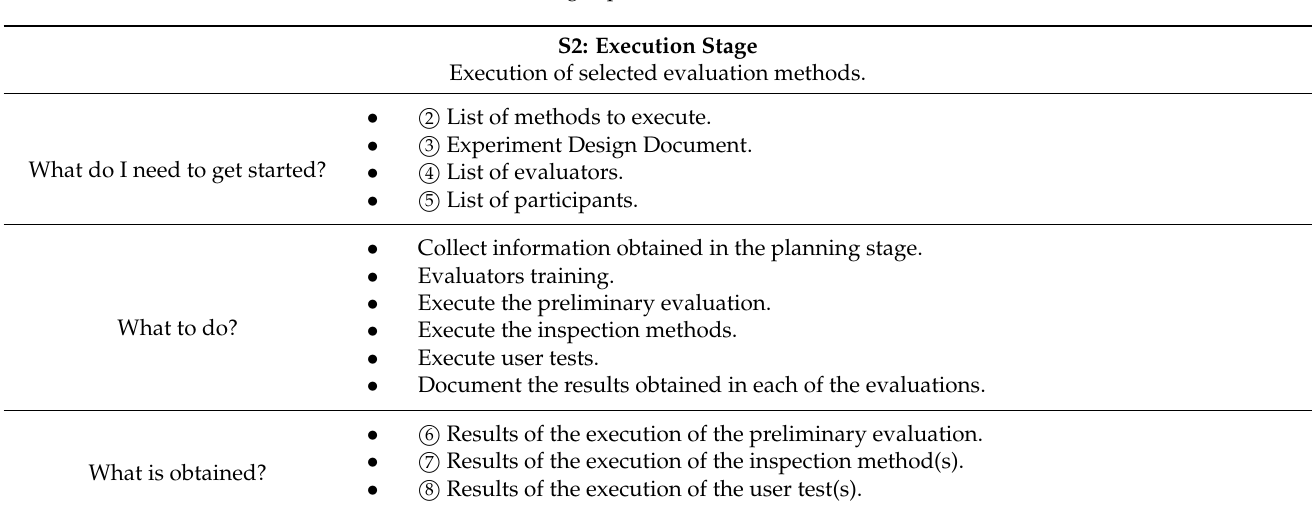
Table A7. Execution Stage